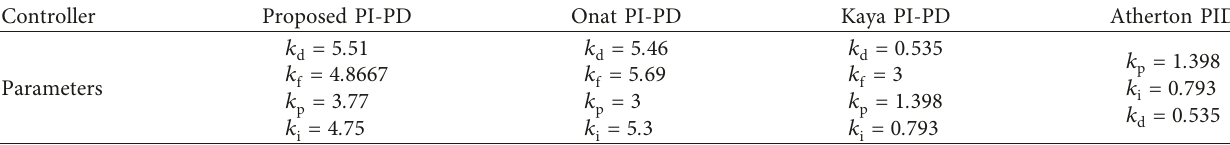
Table 3: Controller parameters comparison of various methods in example B (other data cited from [34]). Controller